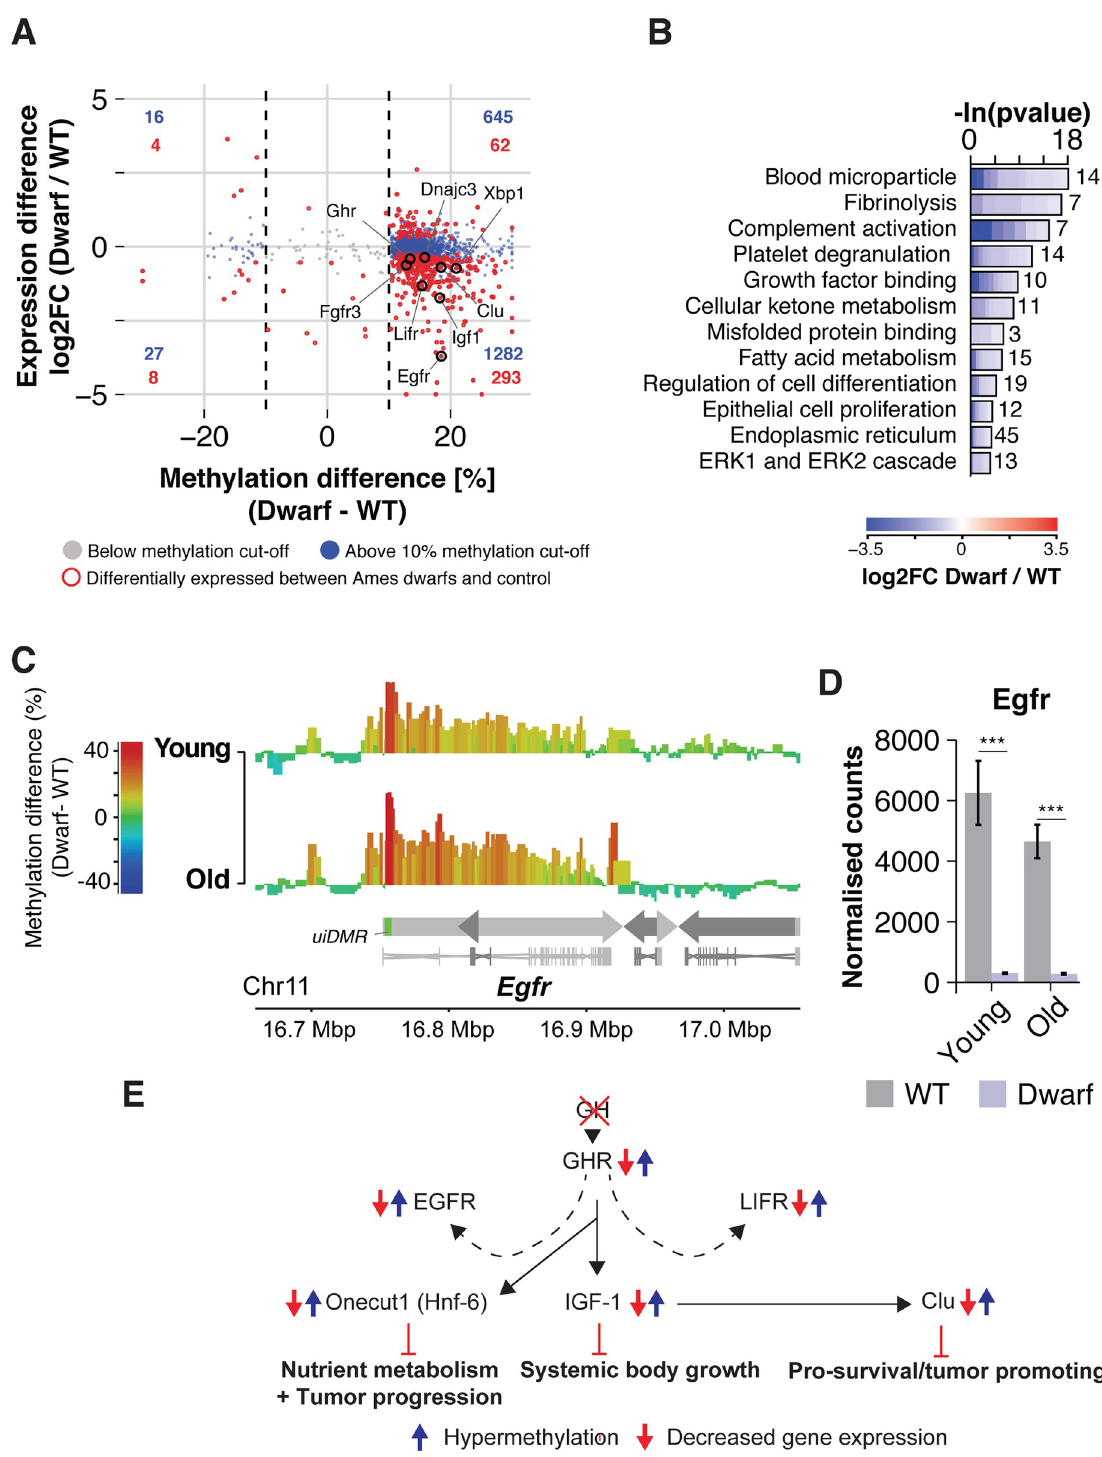
Fig 4. DNA methylation differences in Ames dwarf mice predict expression changes. (A) Scatterplot of expression differences versus methylation differences of dwarfism-related DMRs. Dashed lines indicate DNA methylation cutoff of > ± 10%. DNA hypermethylation associated significantly with reduced gene expression ( Binomial test p < 0.001). Number of differentially methylated genes in each quadrant is indicated in blue and red, for all genes and differentially expressed genes, respectively. (B) Gene ontology and Reactome enrichment of genes with a negative correlation of gene expression and methylation. Lengths of bars represent negative ln-transformed,